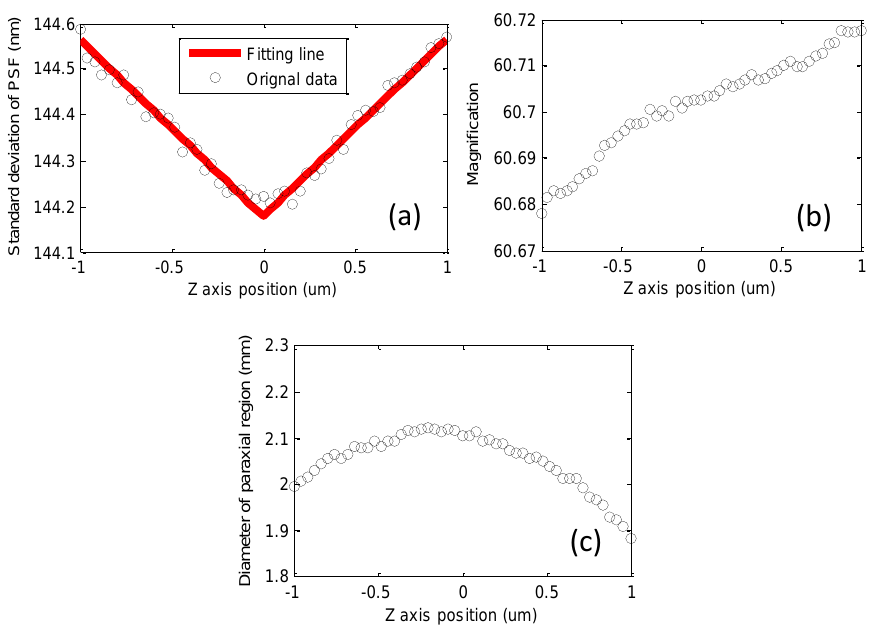
Figure 7. The obtained 3D PSF ( a ), magnification ( b ), and paraxial region ( c ).